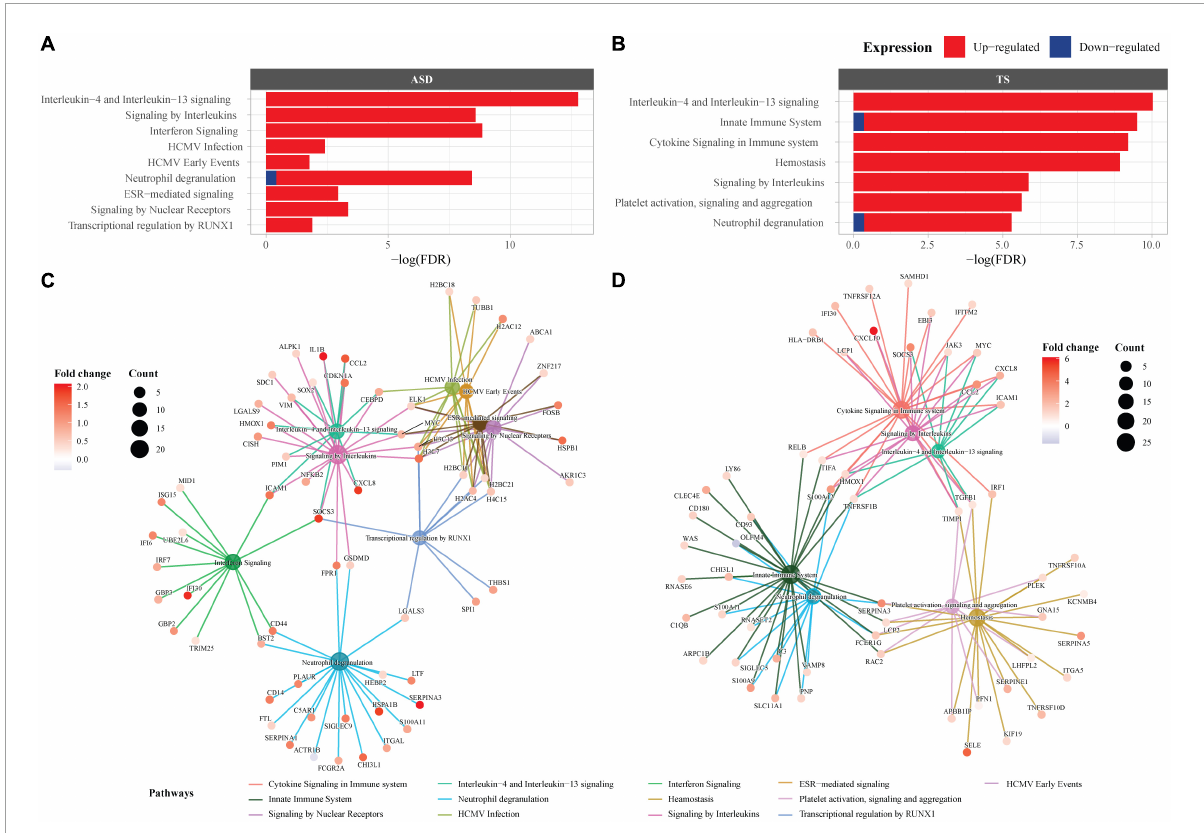
FIGURE2 Pathway enrichment analysis in autism spectrum disorders (ASD) and Tourette syndrome (TS). Reactome enrichment analysis ( FDR < 0.05) of the differentially expressed genes (DEGs) in the brain transcriptome of individuals with ASD compared with controls (A,C) and the DEGs of individuals with TS compared with controls (B,D) . Panels (A,B) : ASD enrichment results (A) and TS enrichment results (B) presented as bar plots of the top 10 pathways (y-axis), with the statistical significance of the pathways presented by the x-axis. Panels (C,D) : Connectivity network (CNET) plots of the top 5 enriched pathways and the interactions of genes that make up the pathways, represented by each gene’s fold change. The enriched pathways in ASD (C) and TS (D) are represented by a